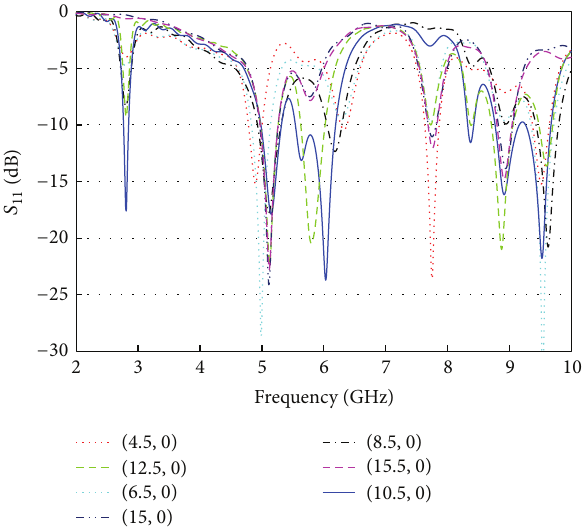
Figure 3: Effects of feed line width (𝑤𝑓)